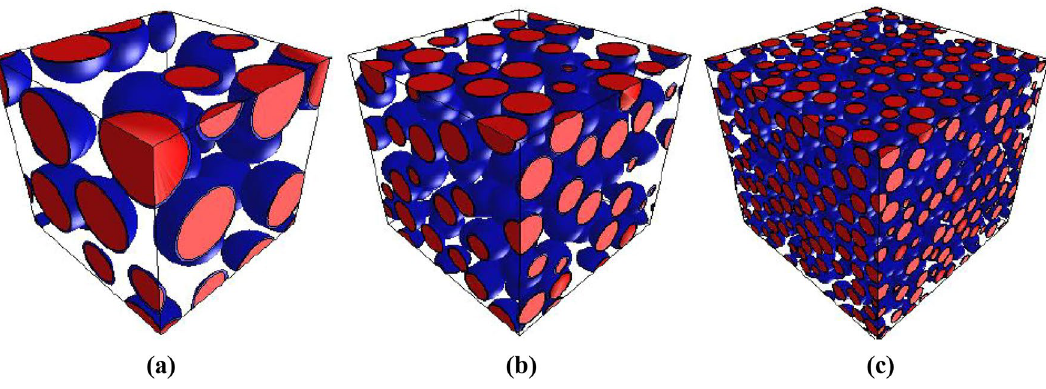
Figure 4. RVE sizes of mortar at mesoscale: ( a ) 2.5, ( b ) 5, and ( c ) 10